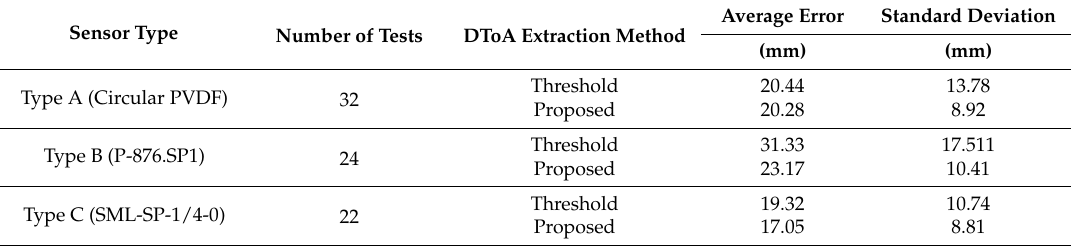
Table 1. Comparison of the impact localization results obtained on the same data using a simple threshold method vs. the proposed algorithm.